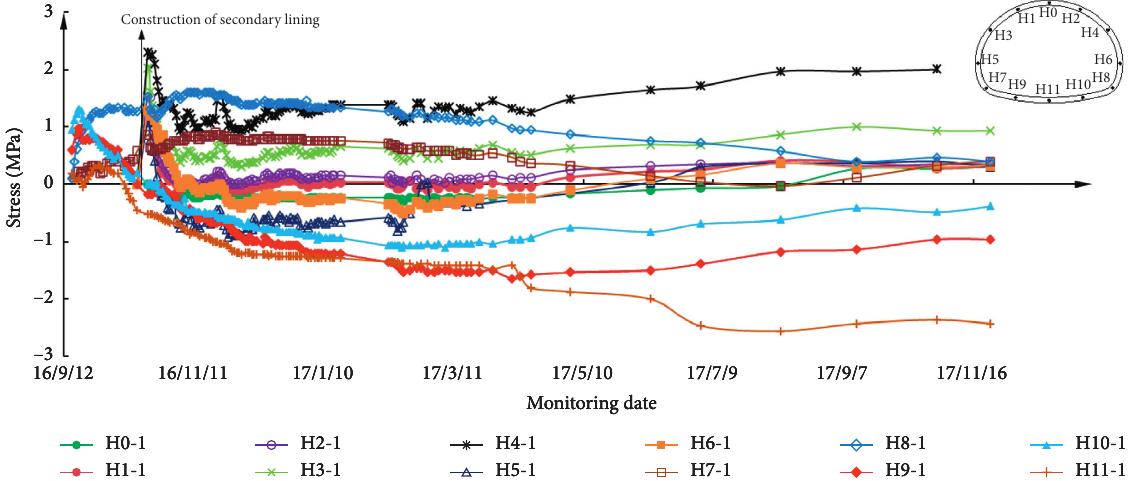
Figure 21: Time curve of secondary lining concrete (outside) in YK2+ 133 section.